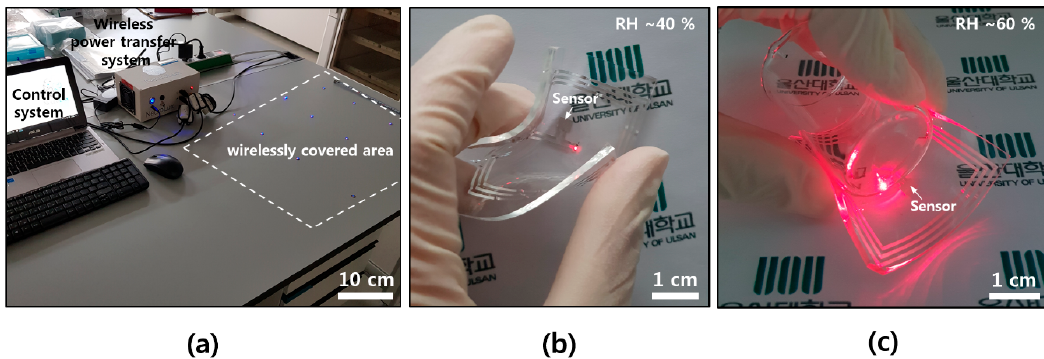
Figure 4. Wirelessly operated humidity sensor ( a ) NFC-based wireless humidity sensor device and its circuit diagram; ( b ) humidity-sensing operation with red LED indicator as a function of RH ~18%, ~39%, ~56%, and ~74%.